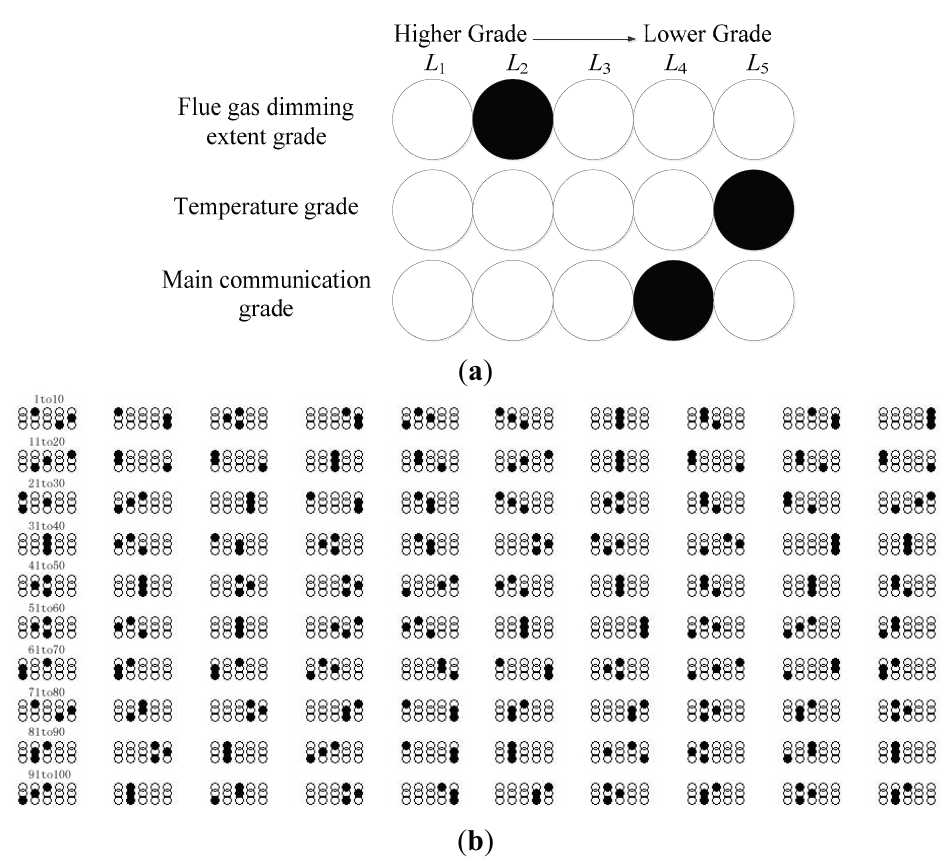
Figure 13. The output from AF-DHNN. ( a ) No.1 node’s status; ( b ) all nodes’